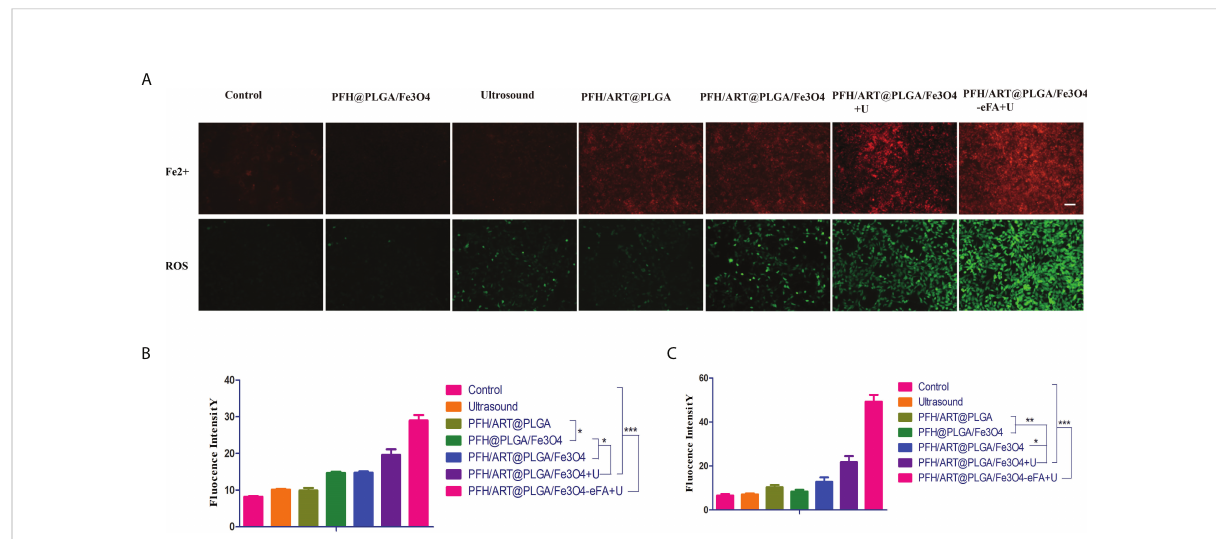
FIGURE 7 In vitro 4T1 cell therapy under different conditions. (A) Inverted fl uorescence microscopyimages of 4T1 cells were collected to visualize intracellular Fe 2+ ion generation using the Fe 2+ fl uorescent probe ferrorange. Red fl uorescence indicates intracellular Fe 2+ ions in 4T1 cells (upper row). The scale bar is 100 nm. Measurement of intracellular ROS levels with the DCFH-DA probe after different treatments. Green fl uorescence indicates ROS levels in 4T1 cells (bottom row).The scale bar is 100 nm. (B) Quantitative analysis of the red fl uorescence intensity of the intracellular Fe 2+ ions in 4T1 cells after different treatments. (C) Quantitative analysis of the red fl uorescence intensity of ROS level in 4T1 cells after different treatments. The levels of signi fi cance wereset to values of *p < 0.05, **p < 0.01, and ***p < 0.001. The data are shown as the mean ± s.d. n =